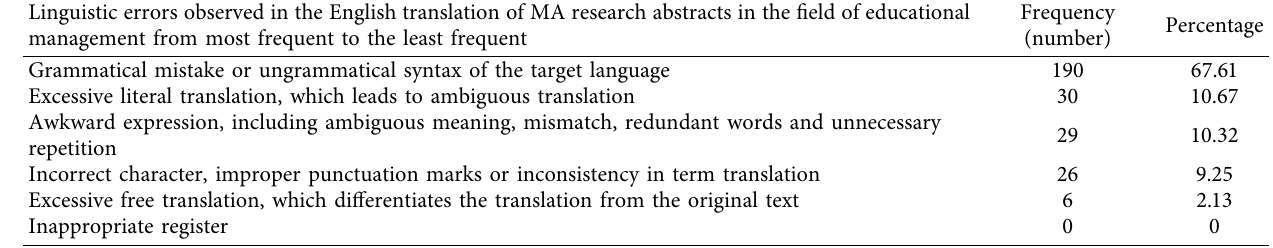
Table 8: Most-least frequent linguistic errors observed in the English translation of MA research abstracts in the field of educational management based on Liao’s (2010)